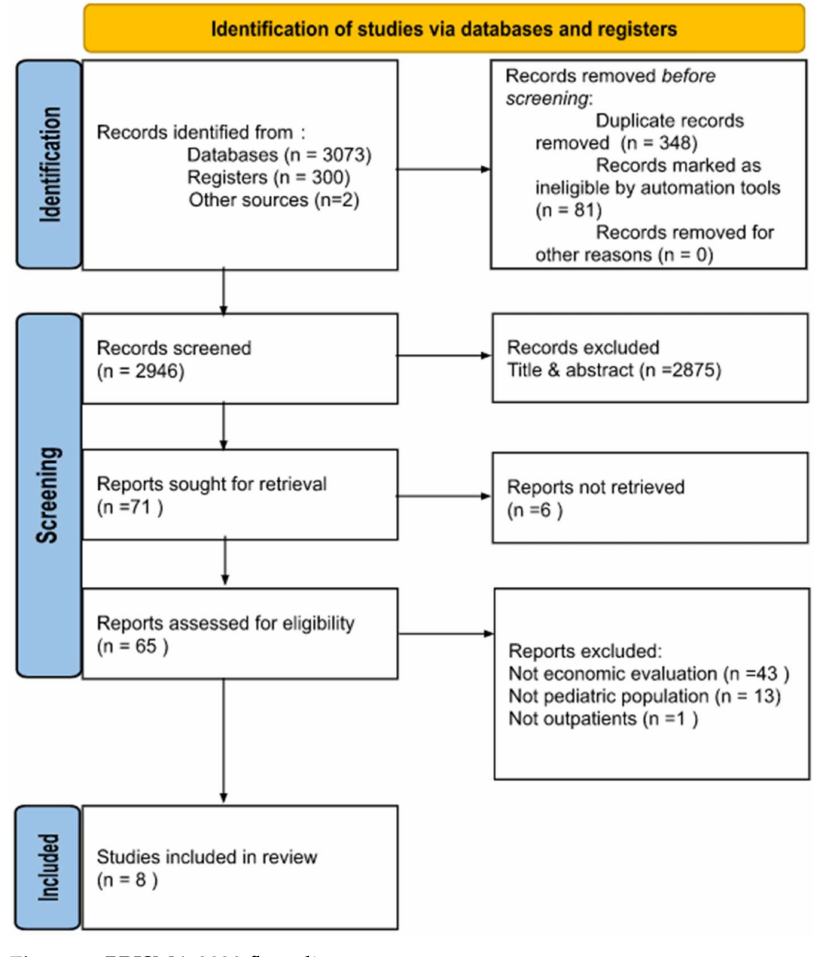
Figure 1. PRISMA 2020 flow